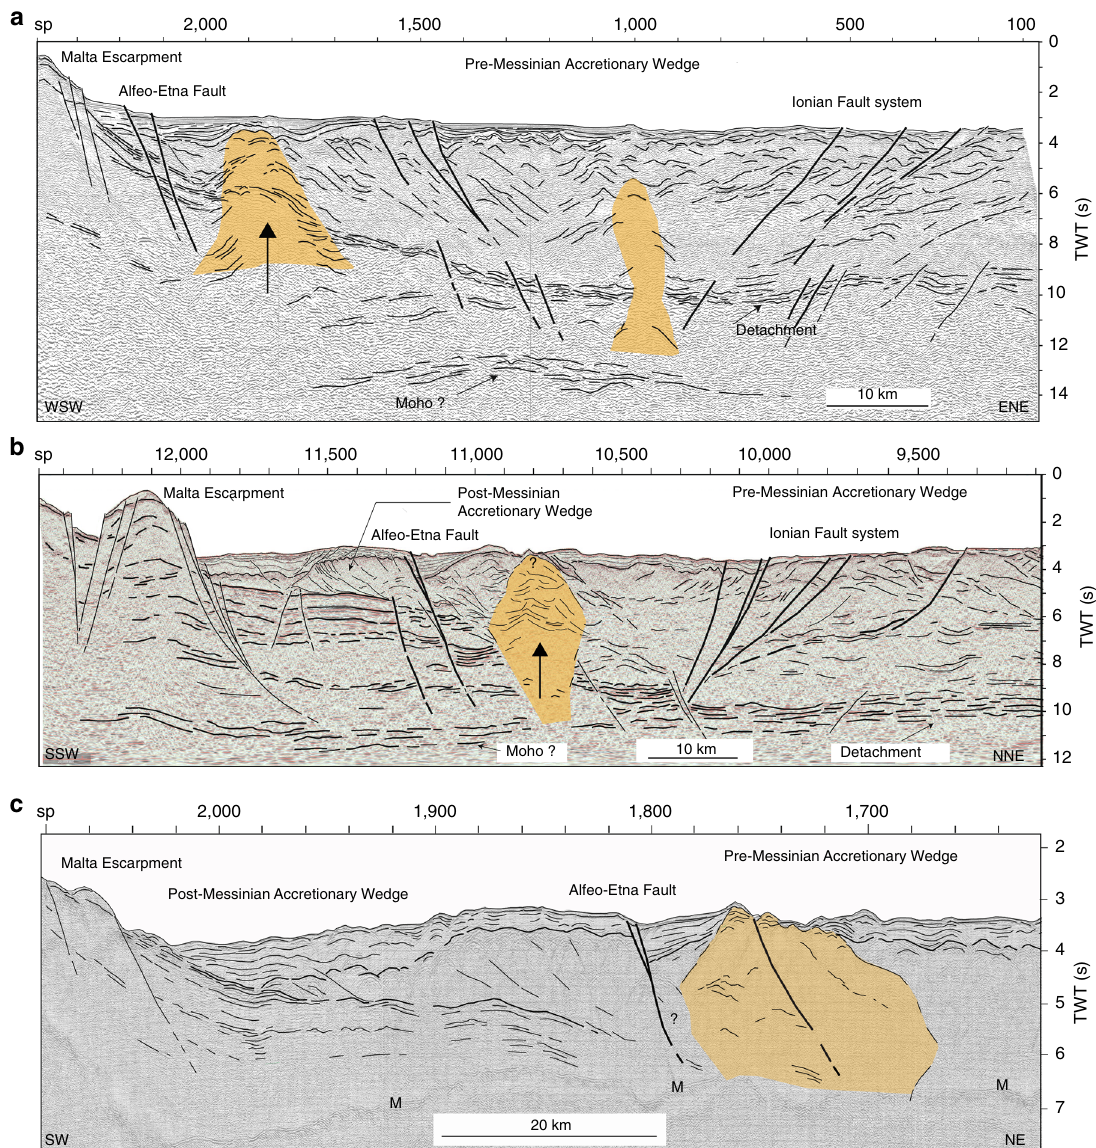
Fig. 3 Line drawings of time migrated MCS lines used for structural reconstructions in Areas-1 and -2. Location of seismic pro fi les is shown in Fig. 2. Yellow/brown pattern: diapiric features. a ETNASEIS-6 MCS line collected orthogonal to the continental margin SE of Etna. This line crosses the entire WL of the accretionary wedge intercepting both the Alfeo-Etna and Ionian faults. Such faults control extensional processes, which are associated with a shallower Moho at about 11 s TWT. A second diapiric feature is present in the centre of the rifting zone. b CA-A MCS line collected across the WL of the Calabrian Arc subduction complex orthogonally to the AEF. A re fl ector at about 11 s TWT is interpreted as the Moho re fl ection. c MS-26 MCS line across the AEF north of the Alfeo Seamount. M, multiple. The diapir corresponds to a very rough sea fl oor morphology. Bold lines: major trans-tensional faults controlling rifting